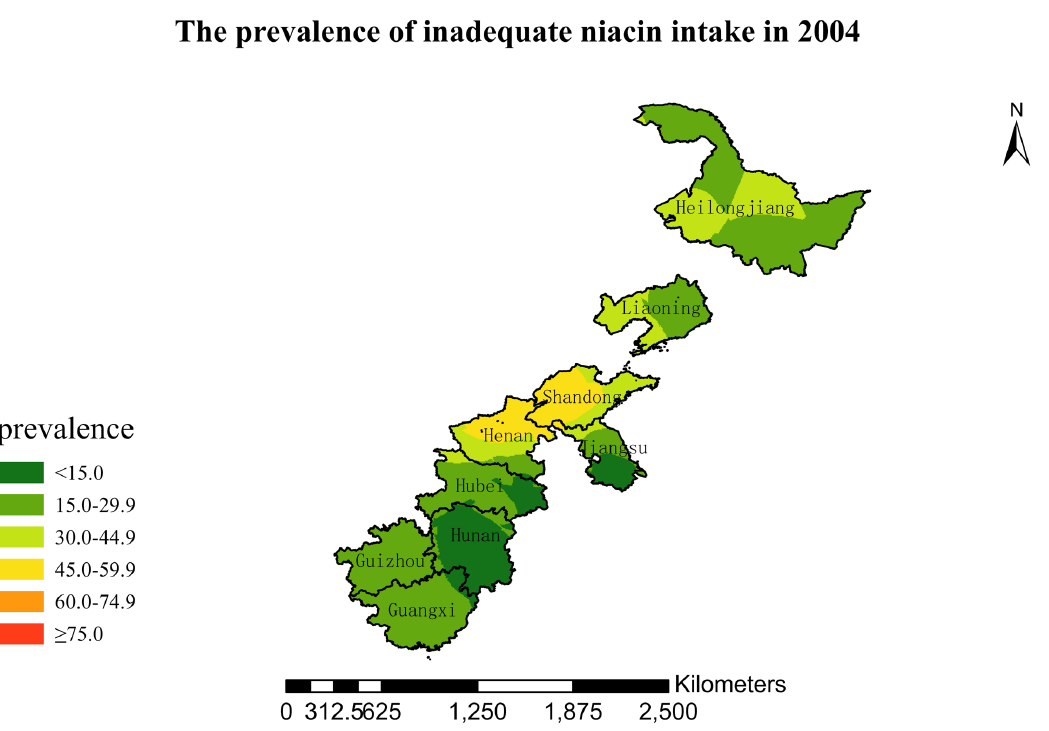
Figure 5. The prevalence of inadequate niacin intake by county in 2004 among Chinese Residents ≥ 5 Years of Age.